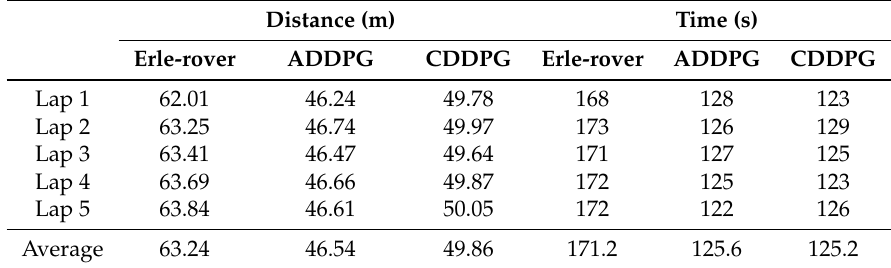
Figure 5. Validation odometry information in a simulated environment. Numbers depict the sequence in which the robot needs to navigate to designated points. The green path visualizes the trajectory of each respective method. ( a ) Experimental results of the Erle-rover laser-based method. ( b ) Experimental results of the ADDPG sparse laser-based method. ( c ) Experimental results of the CDDPG depth image-based method. Table 2. Experimental results for each method over individual laps and average score. Distance is expressed in meters and time in